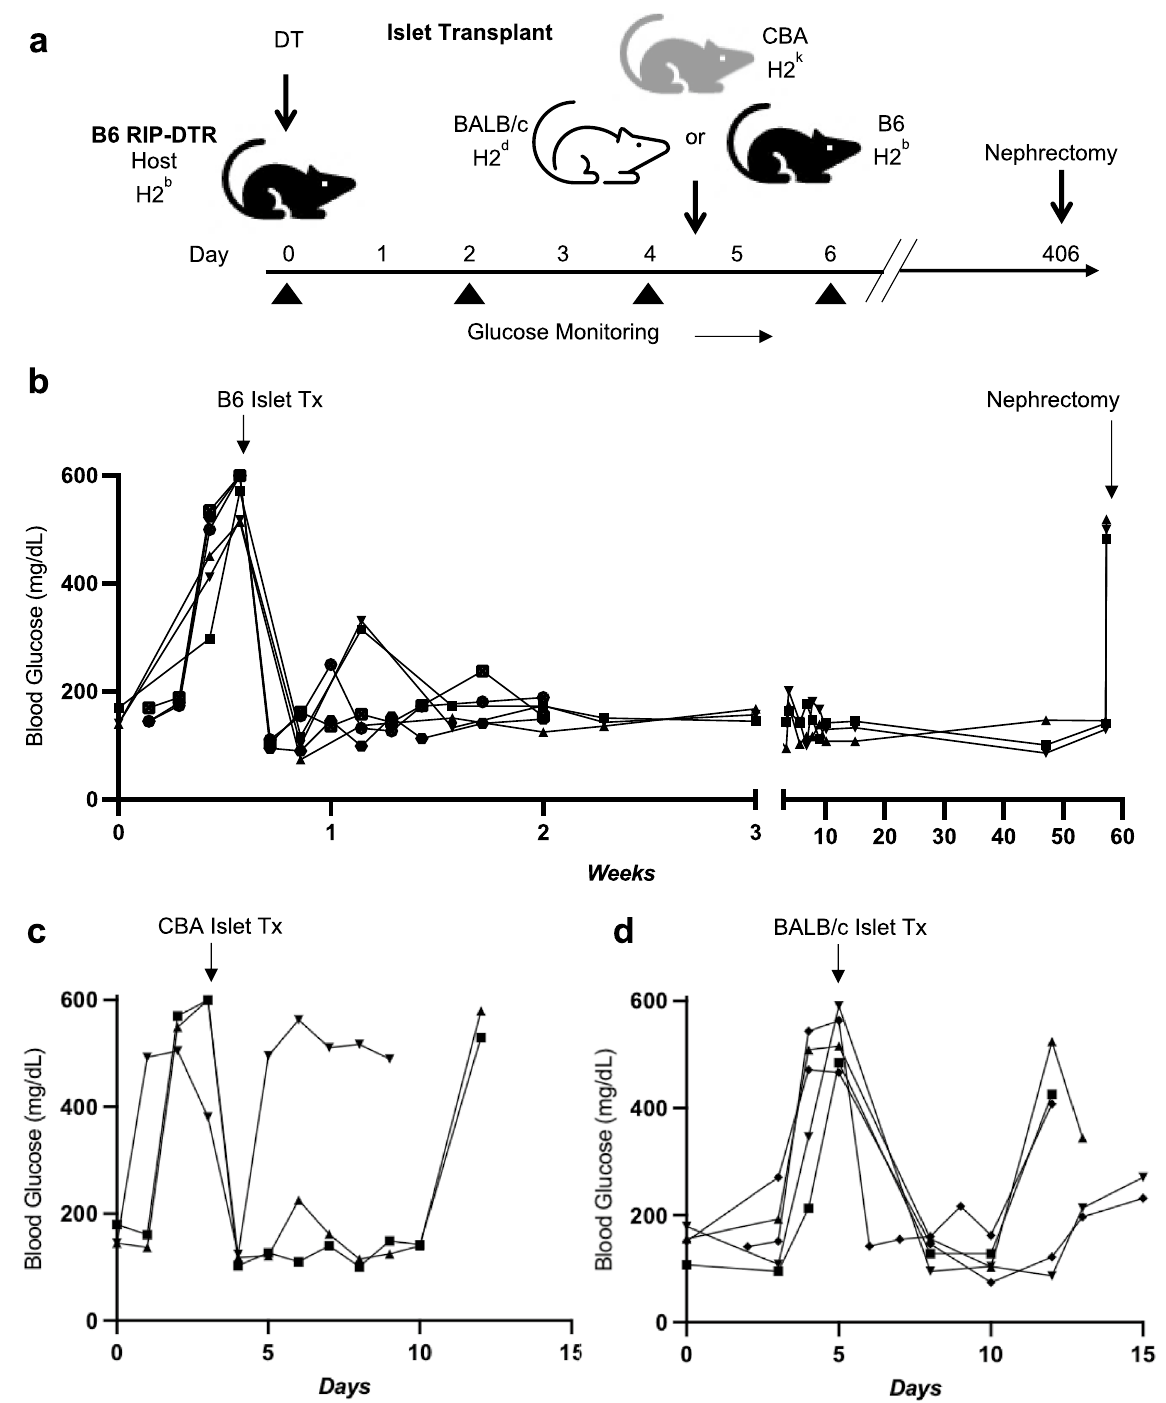
Figure 3. Islet transplantation in diabetic B6 RIP-DTR mice. ( a ) Schematic of congenic and allogeneic islet transplantation in diabetic B6 RIP-DTR mice. ( b ) Male RIP-DTR mice (n = 6; age 10–24 weeks) were injected with DT on day 0 and transplanted with C57BL/6J islets on day 4 after confirmation of hyperglycemia. Mice (n = 6) were monitored for about 2 weeks post-transplant. Mice (n = 3) were monitored for approximately another 1 year, until nephrectomy was performed at 56 weeks post-transplant to remove the islet graft. ( c ) Male RIP-DTR mice (n = 3; age 24 weeks) were injected with DT on day 0 and transplanted with allogeneic CBA/J islets on day 4 after confirmation of hyperglycemia. Mice were monitored for repeat hyperglycemia for up to 14 days. ( d ) Female and male RIP-DTR mice (n = 5; 4F, 1M, age 10–24 weeks) were injected with DT on day 0 if female and day 1 if male and transplanted with BALB/c (allogeneic) islets on day 5 after confirmation of hyperglycemia. Mice were monitored for repeat hyperglycemia for up to 14 days. In all cohorts, a single dose of exogenous insulin (40 U/kg) was administered on the morning of islet transplantation following confirmation of hyperglycemia. No further exogenous insulin treatment was